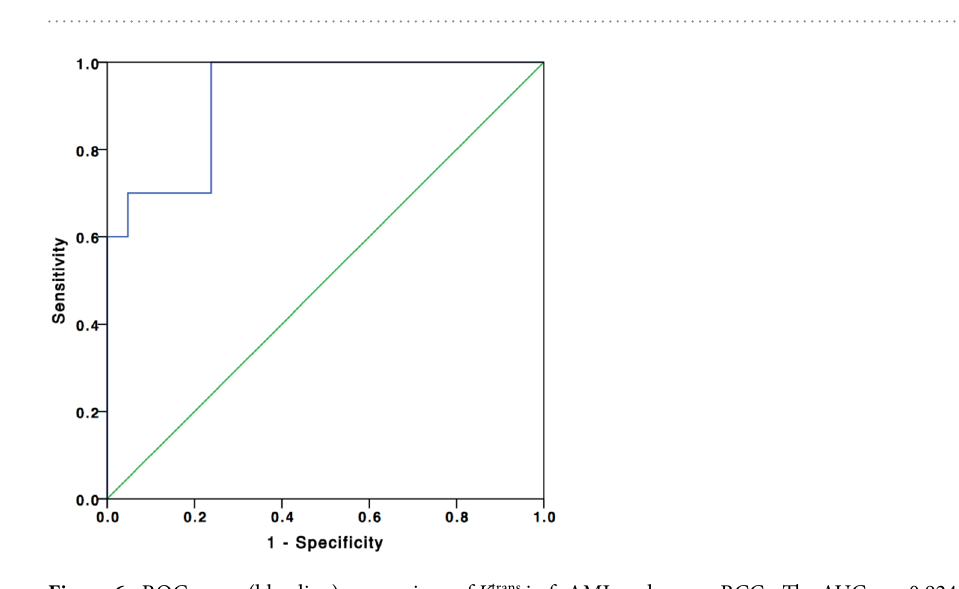
Figure 6. ROC curve (blue line) comparison of K trans in fpAML and non-ccRCCs. The AUC was 0.924. When the threshold K trans value was 0.365 min − 1 , the sensitivity and specificity were 100% and 76.2%, respectively. When the K trans value was greater than 0.427 min − 1 , the sensitivity and specificity were 70.0% and 95.2%,